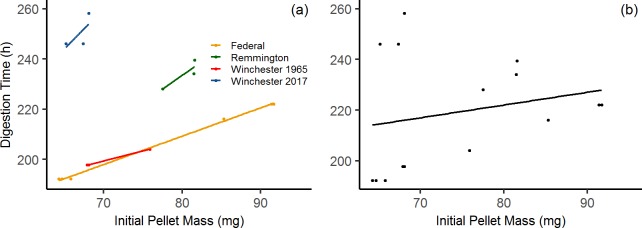
Individual and cumulative trends in total dissolution time compared to initial pellet mass.(a) Individual brand trends, where positive correlation is strongest in the Federal (2011) brand, likely due to larger sample size (n = 6). Correlation coefficients for each brand are as follows: Winchester (1965): r2 = 0.472; Winchester (2017): r2 = 0.986; Remington (2017): r2 = 0.793; Federal (2011): r2 = 0.998; (b) Cumulative trends (n = 16). Correlation coefficient for the overall trend is: r2 = 0.049.